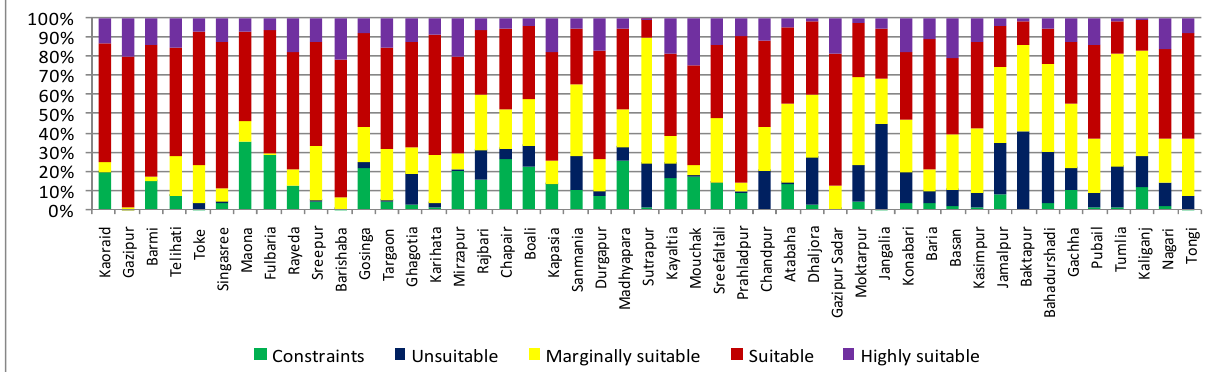
Source: Khaleda and Murayama [12]. Figure 5. Relative area (in percentage) with suitability for poultry farm microenterprises by administrative unions in